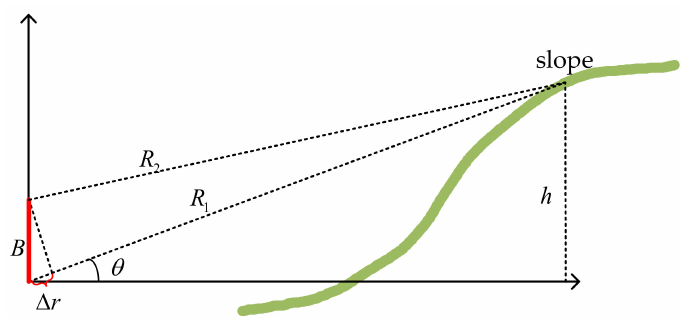
Figure 1. Geometric schematic of GB-InSAR